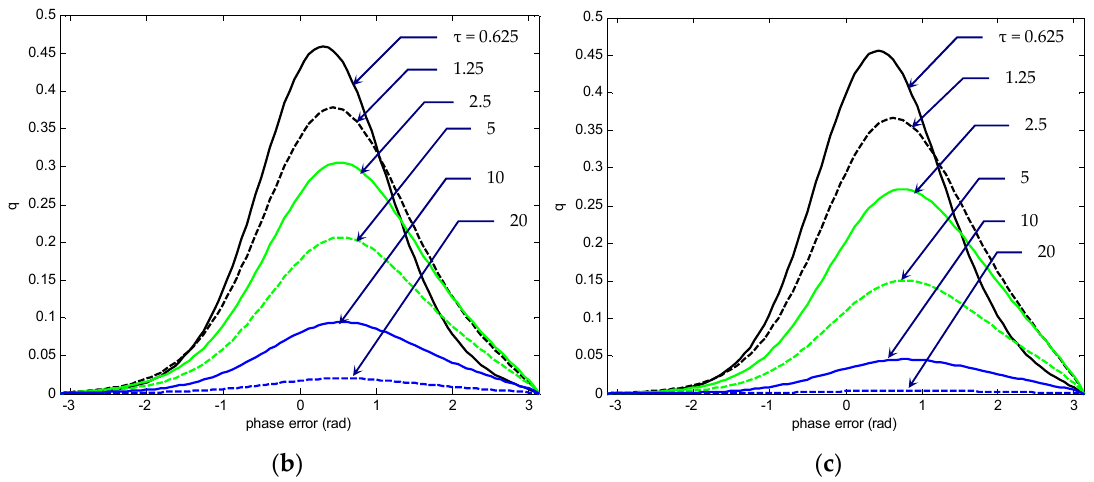
Figure 20. The time-evolution of primary cyclic slipping density function q ( φ , τ ) for SNR α = 1: ( a ) γ = 0; ( b ) γ = sin ( π /4 ) ; and ( c ) γ = sin ( π /2 ) .